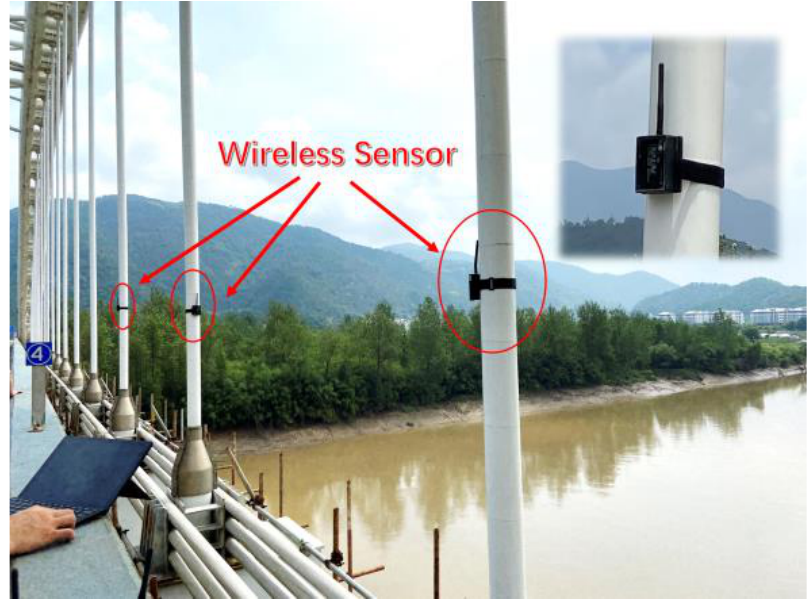
Figure 4. Field test of suspender cable force.